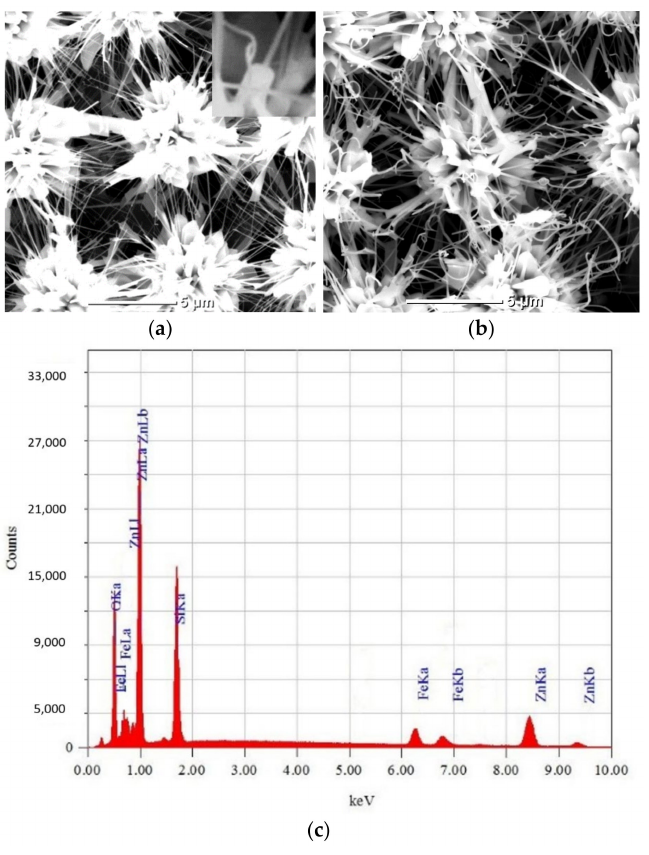
Figure 4. Electron microscopic images of the surfaces of samples of ZnO type II pure ( a ) and with Fe 2 O 3 ( b ). ERM data for a type II ZnO sample with Fe 2 O 3 ( c ). Inset ( a ): image of a separate ZnO microrod with a